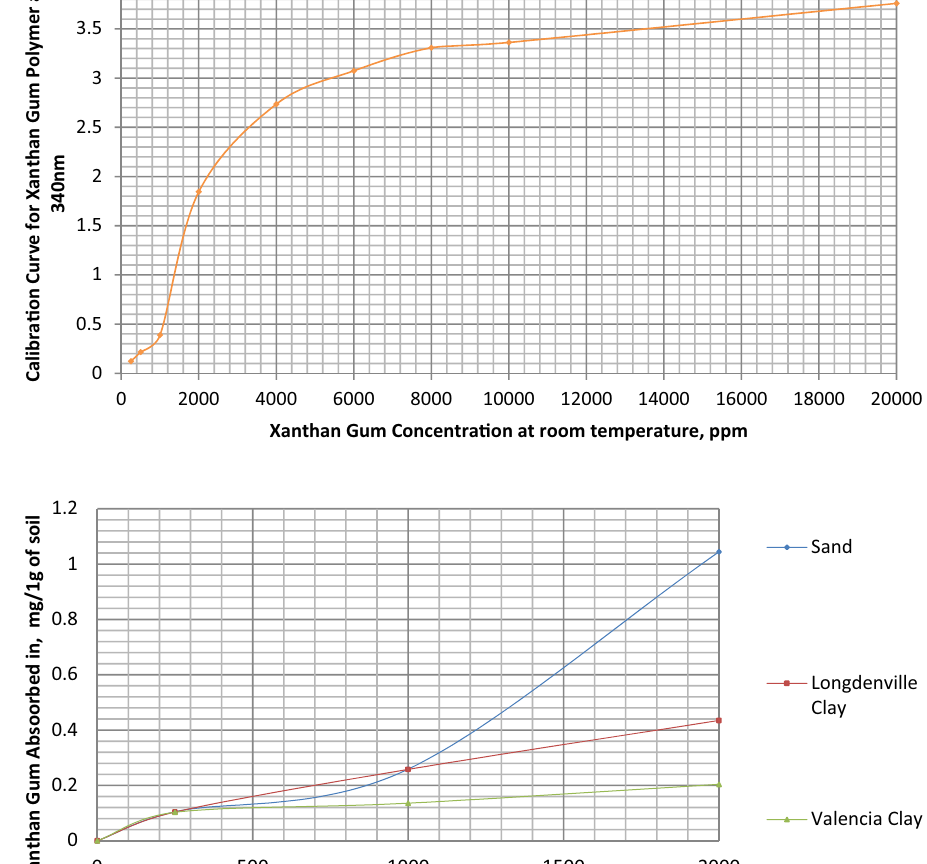
Fig. 6 Xanthan gum polymer calibration curve at 𝜆 max